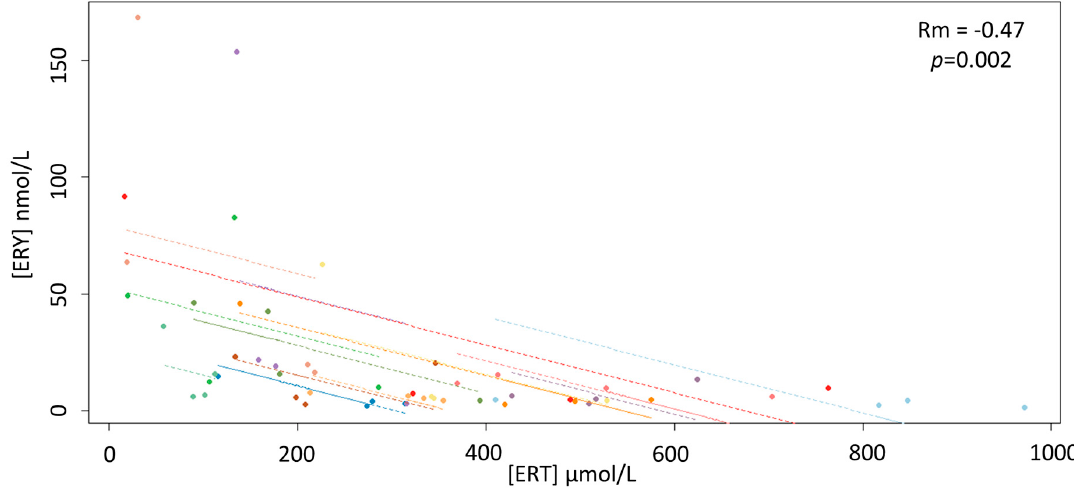
Figure 1. Scatterplots of the linear relationship between the concentrations of ERY and ERT.